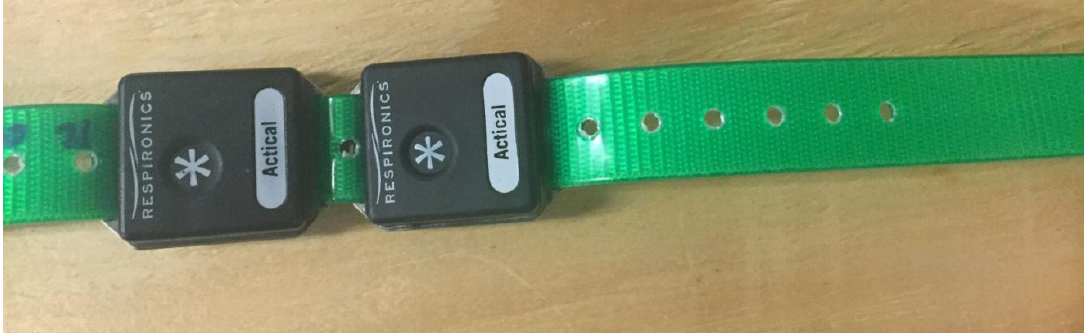
Figure 4. Demonstration of Actical accelerometer placement. For P1, both Actical devices were placed side by side on the same collar with a tight fit.